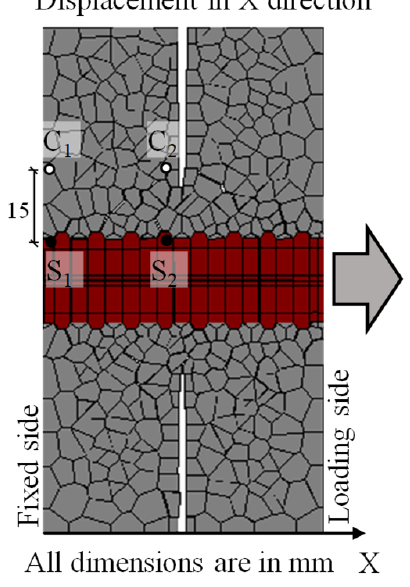
Figure 7. Location of points in concrete and steel at interface for calculation of slip in simulation.